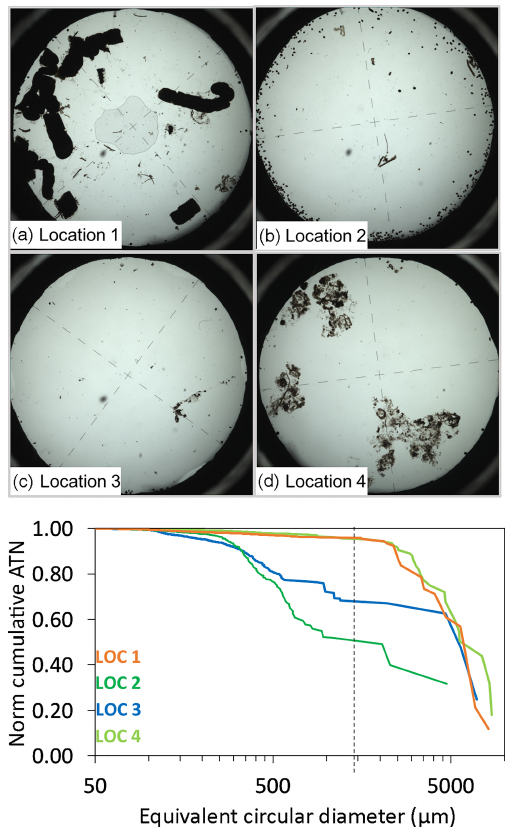
Figure 3. Representative images from four locations. The particle size classes varied widely at the four different locations. (a) In lo- cation 1, flux was dominated by large 1mm diameter anchovy fecal pellets. (b) Flux was dominated by small ovoid pellets 200–300 mi- crons in diameter. (c) Location 3 was characterized by very low flux. Flux was dominated by small particles with the occasional large ag- gregate. (d) Flux was dominated by large aggregates. (e) Cumula- tive normalized volume attenuance vs. equivalent circular diameter curves representative of the four locations. Approximately 95% of flux was carried by aggregates >1.5mm in size at locations 1 and 4. Location 2 had ∼ 50% of flux in the >1.5mm